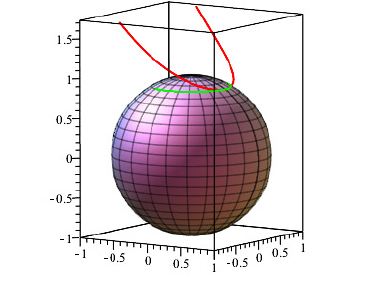
Figure 1. The red curve γ 1 ( s ) is the regular rectifying curve, and the green curve g 1 ( s ) is a curve on S 2 .